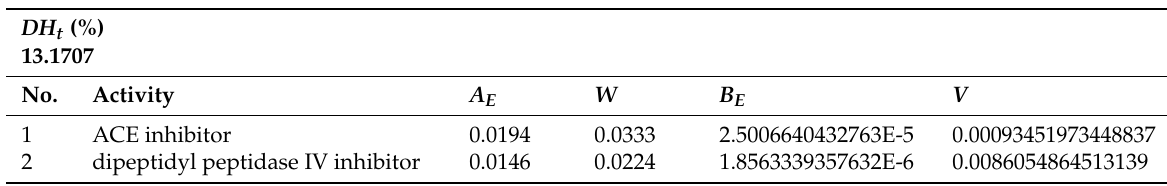
Table A36. A E , DH t , W , B E and V values from RubisCO of Halophila stipulacea . In silico enzymatic cleavage was carried out by using pancreatic elastase II.